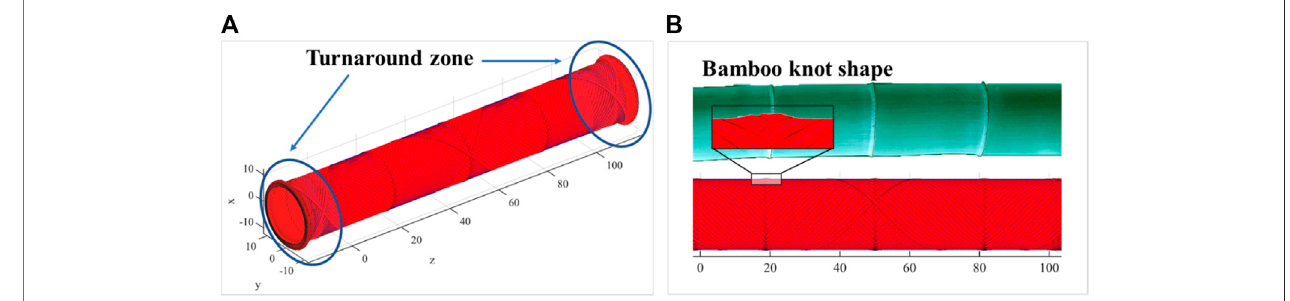
FIGURE 6 | (A) Simulated 3D path of yarn in wound preform; (B) the winding pattern has a “ bamboo knot ” shape.